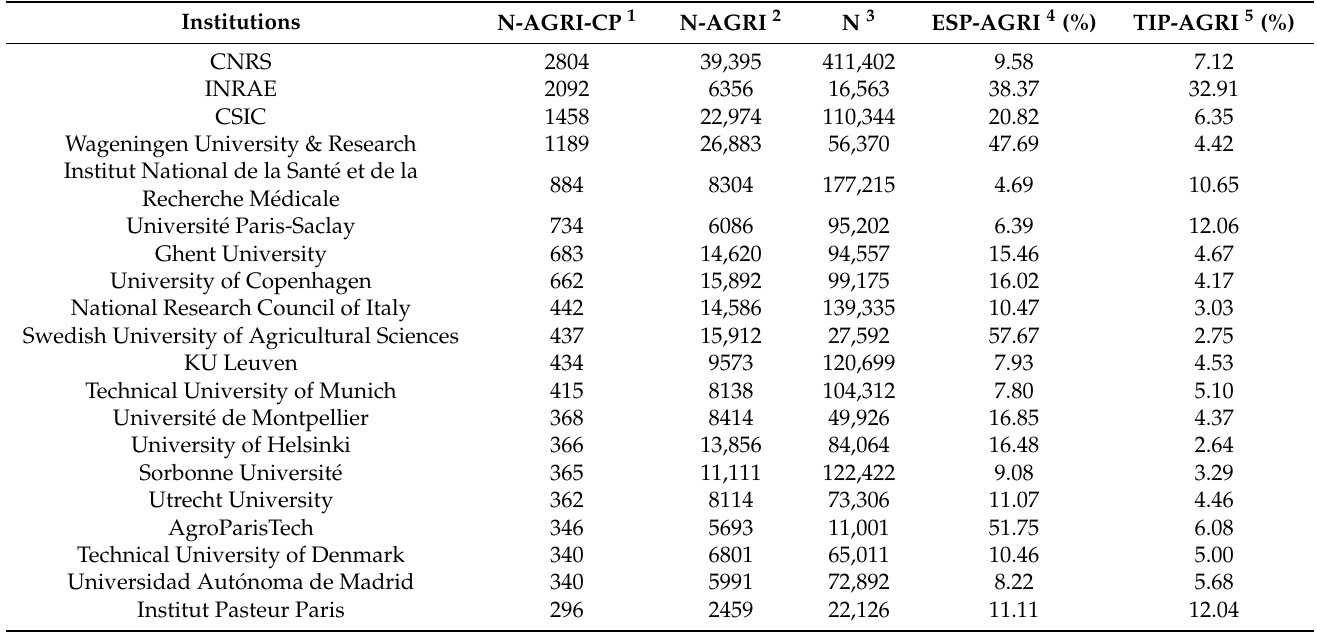
Table 1. Agricultural and Biological Sciences Transference Index in Patents